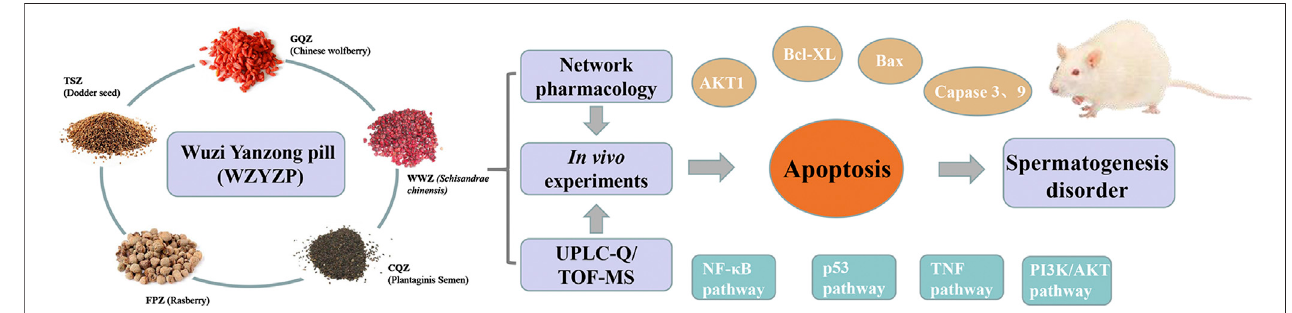
FIGURE 7 | The WZYZP has a curative effect on spermatogenesis disorder via the regulation of apoptosis pathway.